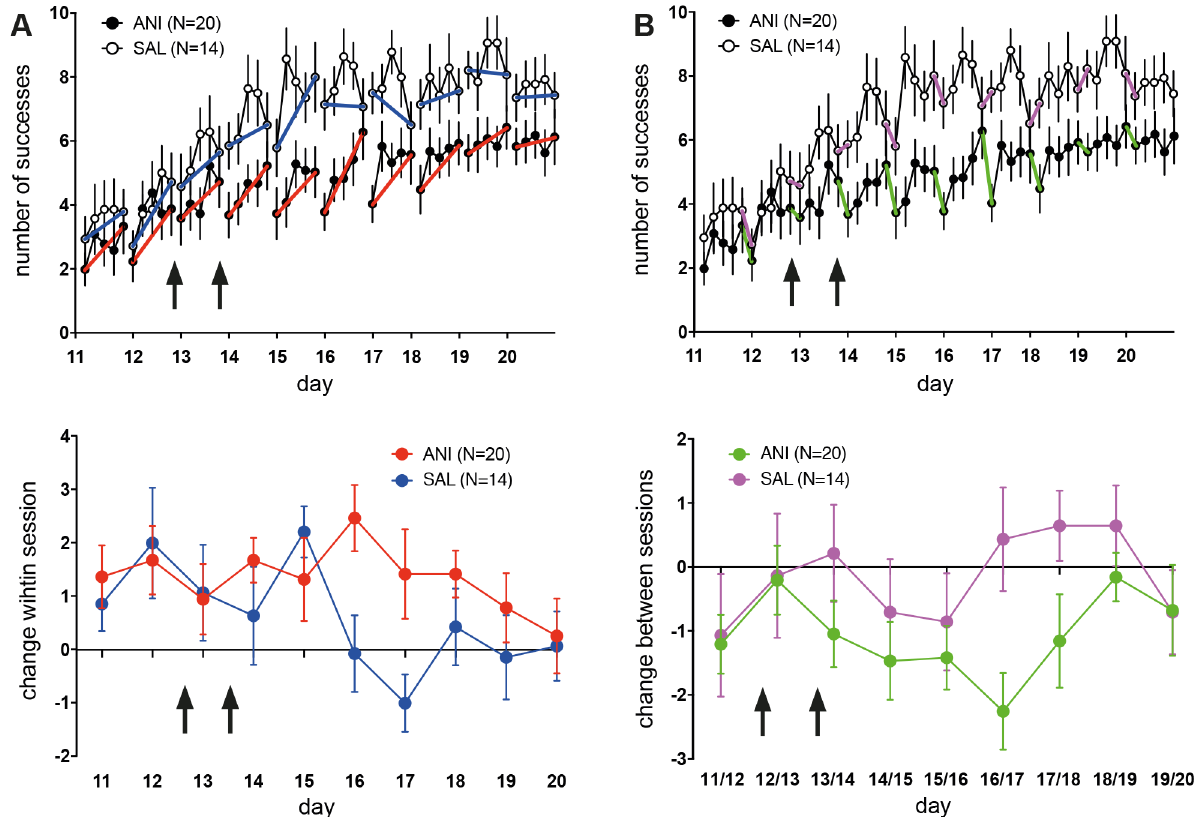
Fig 4. A top and bottom To assess intra-session improvement of grasping performance, sessions were divided into 20-trial bins. The percentage of successful grasps is plotted per bin. Intra-session improvement is indicated by blue (SAL) and red lines (ANI). Injection of ANI (filled circles) did not interfere with intra-session improvement consistent with a preserved ability for short-term plasticity. Changes in motor performance within session occur until day 19 after injection of ANI. In contrast, within-session changes drop to zero in SAL animals when they reach plateau on day 16. Values are presented as mean ± SEM. Arrows indicate the time-point of injections. Values represent mean ± SEM. B top and bottom The magnitude of decrease in performance between the end of a training session and the start of the subsequent session is inversely correlated with the efficacy of motor memory retention. For SAL animals (open circles), retention between remains largely stable throughout the recovery period as indicated by magenta lines. In ANI rats, retention gets worse after ANI injections are started and normalize after session 18 and 19. Values are presented as mean ± SEM. Arrows indicate the time-point of injections. Values represent mean ±